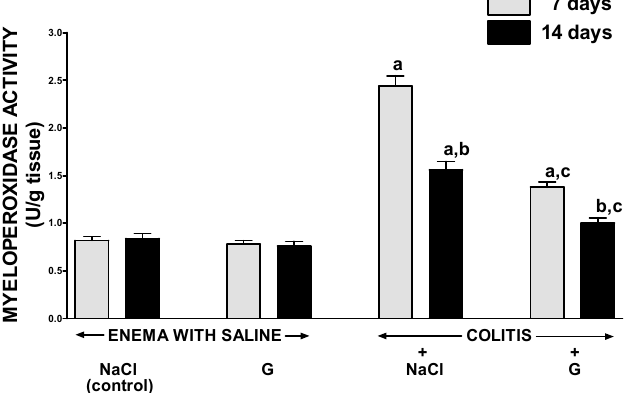
Figure 7. Effect of intraperitoneal administration of saline (NaCl) or ghrelin (G) on activity of myeloperoxidase in colonic mucosa after seven or 14 days from enema with saline or colitis induction. Mean value ± SEM. n = 10 animals in each group. a p < 0.05 compared to control at the same time of observation; b p < 0.05 compared to a value observed at the same group after seven days from colitis induction; c p < 0.05 compared to rats with colitis treated with NaCl at the same time of observation.